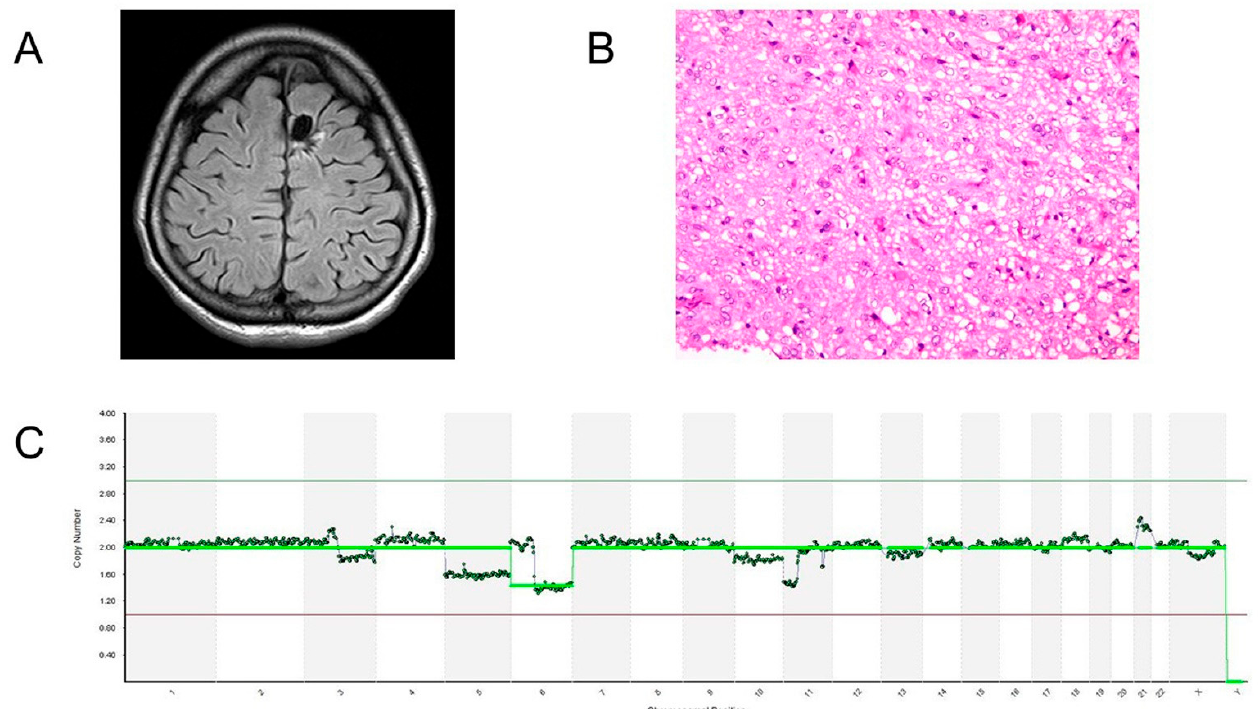
Figure 5. Postoperative radiological, histological, and molecular examinations. ( A ) A postoperative FLAIR image reveals that the tumor was totally resected. ( B ) The histological image of hematoxylin- eosin stain for the resected tumor is demonstrated. ( C ) The figure indicates the result of copy number analyses based on NGS for the resected tissue. A vertical axis indicates the calculated copy number and a horizontal axis shows the chromosomal number.